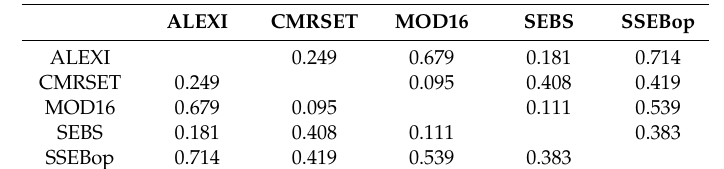
Table 5. Pearson correlation coefficient of annually averaged ET act pixel values in the entire Red River basin. Bold values are higher than 0.5.